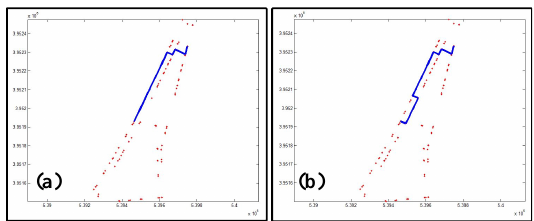
Figure 3. Comparison of the best route for two experimental cases: (a) Male-40-Residential (b) Female-25-Open Areas Second phase of the experiment was assessment of the suggested route by the proposed method in comparison to the best feasible routes in terms of each criterion separately. Again, the experimental case for the 40-year-old male was considered and the path that is suggested for him by the application (Figure 4-a) was compared with the shortest route (Figure 4-b), safest route according to the Accident Safety (Figure 4-c), safest route according to the Social Safety (Figure 4-d), easiest route (Figure 4-e) and the most attractive route (Figure 4-f).